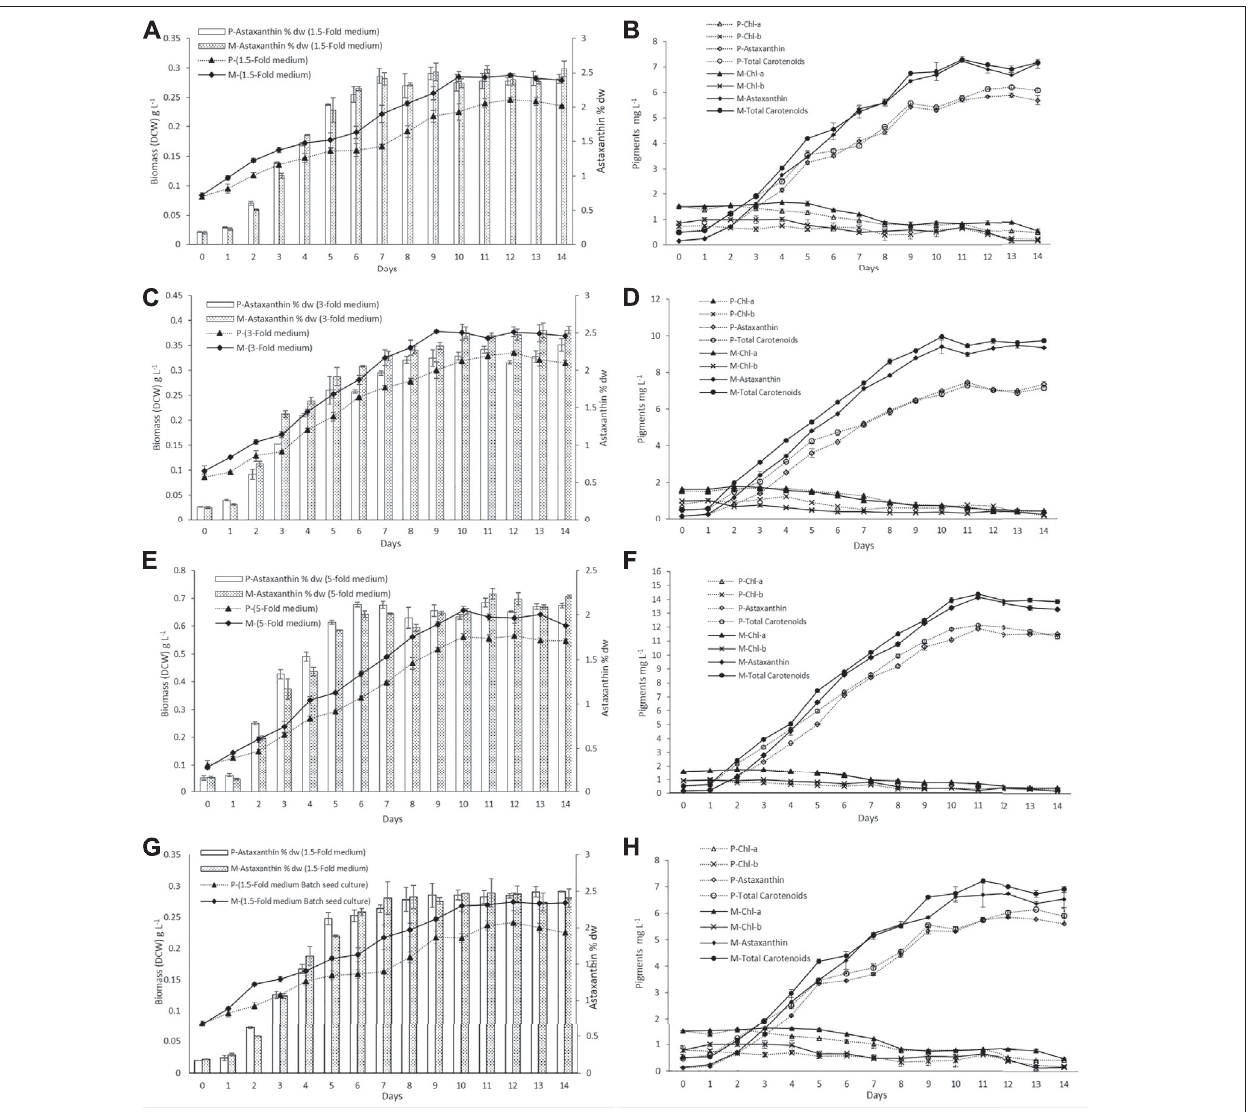
FIGURE 3 | Dry cell weight and pigment pro fi les of H. lacustris grown in outdoor ORPs, with phototrophically grown seed cultures (labeled with P) and mixotrophically grown seed cultures (labeled with M). (A) Biomass DCW and astaxanthin content % DW pro fi les in 1.5-fold medium; (B) pigment pro fi les in 1.5-fold medium; (C) biomass DCW and astaxanthin content % DW pro fi les in 3-fold medium; (D) pigmentpro fi les in 3-fold medium; (E) biomass DCW and astaxanthin content %DWpro fi lesin5-foldmedium; (F) pigmentpro fi lesin5-foldmedium; (G) biomassDCWandastaxanthincontent%DWpro fi lesofbatchcultivationseedcultures; (H) pigments pro fi le of batch cultivation seed